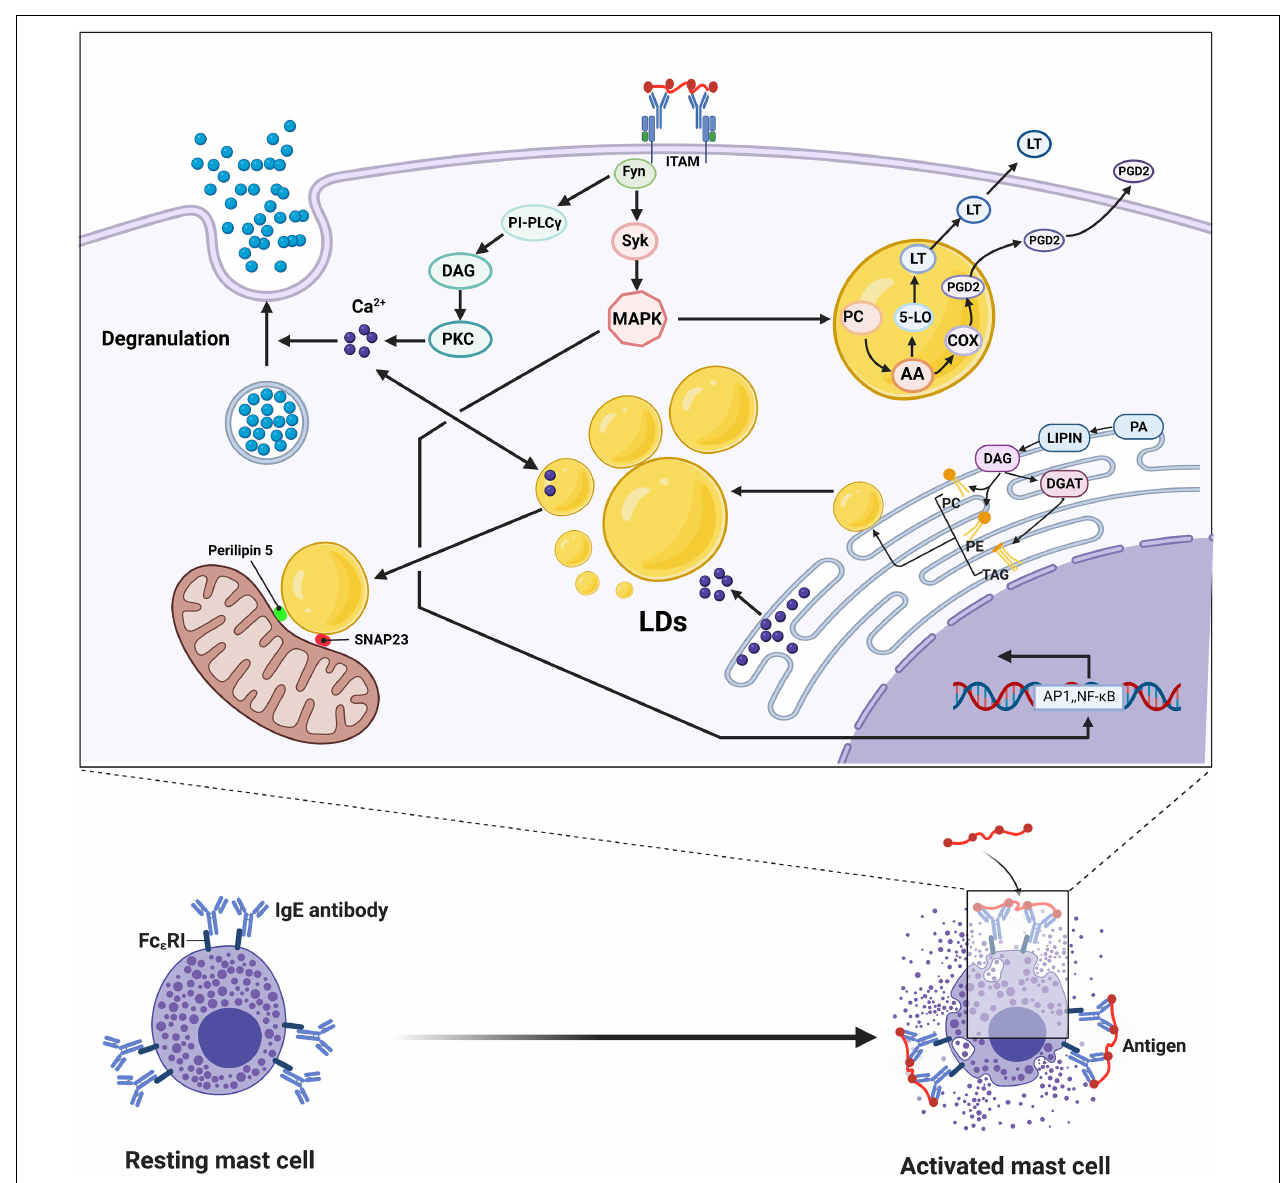
FIGURE 3 | IgE cross-linking mediated activation of mast cells leads to degranulation and release of large amounts of bioactive lipids, including prostaglandin D2 and leukotriene (LT). After Fc ε RI is cross-linked with each other, the phosphorylation of ITAM activates Fyn and Syk, which in turn mediates activation of PKC through the PI-PLC γ signaling chain, resulting in increased intracellular calcium concentration and phosphorylation of the intracytoplasmic myosin light chain, leading to degranulation and release of bioactive mediators. Phosphorylation of ITAM activates the mitogen-activated protein (MAK) kinase signaling pathway, causing the breakdown of phospholipid choline (PC) in the presence of phospholipase A2 to produce arachidonic acid (AA), which is then combined into PGD2 and LT, respectively, via the cyclocythase and lipoxygenase pathways. Activation of MAPK also increases the transcription of several nuclear transcription factors, such as NF- κ B and AP1. After Fc ε RI is cross-linked, LDs are not only the source of calcium ions in mast cells but also the sinks of calcium ions, acting as the source and absorber of calcium ions, thereby affecting the corresponding signal pathways. The LDs-associated proteins Perilipin 5 and SNAP23 play crucial roles in the physical and metabolic connections between LDs and mitochondria. The synthesis of LDs is mainly carried out in the endoplasmic reticulum, accompanied by the synthesis of TAG, PC, and PE with FA as the substrate under the action of various